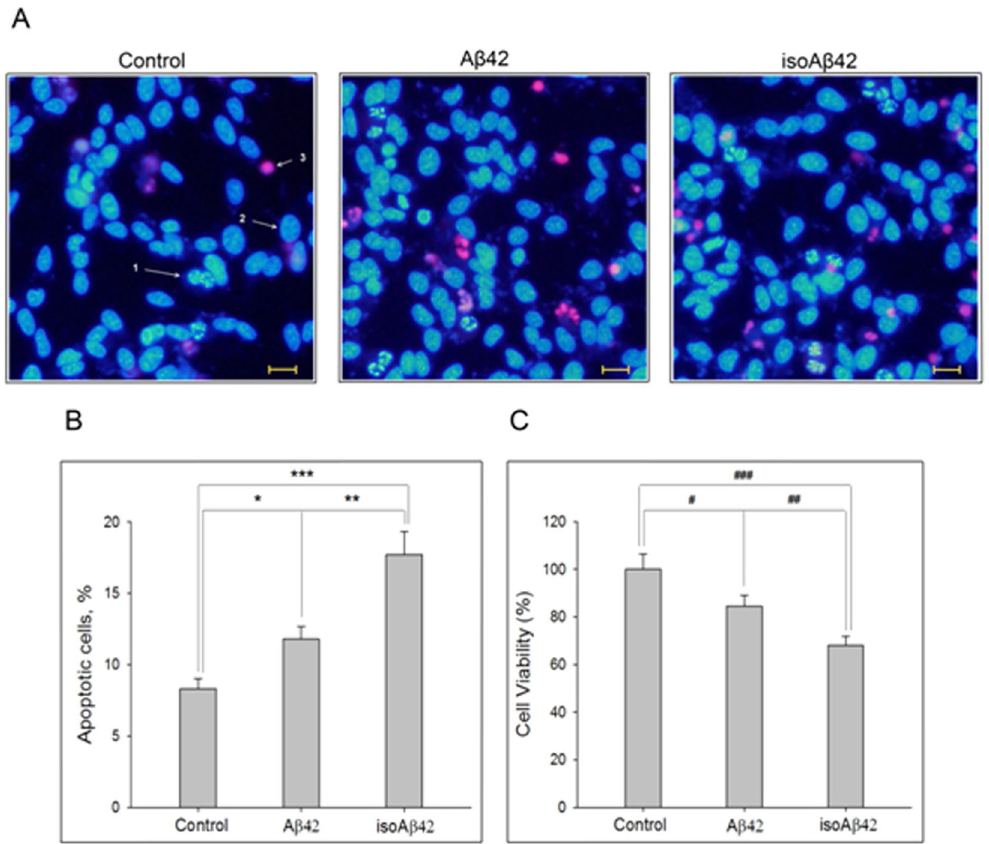
Figure 1. Effects of A β 42 and isoA β 42 (10 µ M) on SH-SY5Y cells. ( A ) Visualization of the cells using fluorescent microscopy. Left, untreated cells. Centre, cells treated with A β 42. Right, cells treated with isoA β 42. Arrows indicate the following: 1 - apoptotic cells stained with Hoechst 33342; 2 - living cells; 3 - necrotic cells stained with propidium iodide. Scale is 20 µ m. ( B ) Number of apoptotic cells in the cell population. Control - untreated cells; isoA β 42 and A β 42 - cells treated with isoA β 42 and A β 42 for 24 h, respectively. ( C ) Viability of the cells in percent, revealed by MTT-test treated with A β 42 or isoA β 42 relative to control without treatment at 48 h. Each value represents mean ± SD of at least three independent experiments performed in quadruplicate; * p < 0.023, ** p < 0.002, *** p < 0.001, # p < 0.005, ## p < 0.003, ### p <